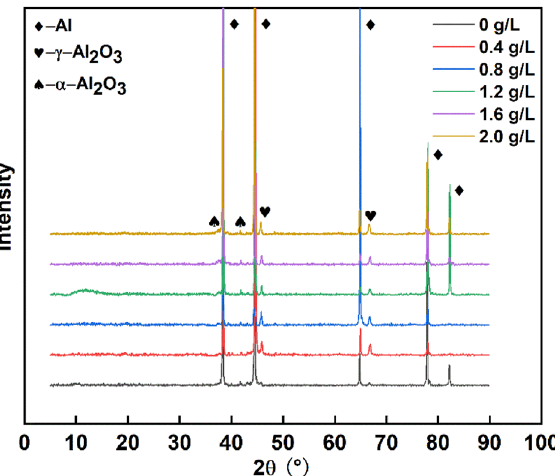
Figure 7. XRD results of the MAO coatings with different concentrations of NCNs (OriginPro 2018, https:// www. origi nlab. com/ index. aspx? go= Produ cts/ Origin).